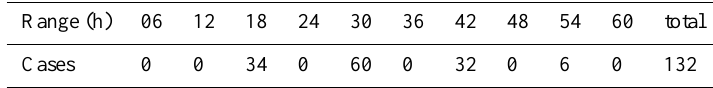
Table 3. Forecasting ranges for the 132 distinct raw cases of the whole